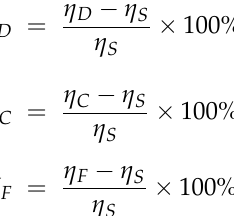
Table 1. Theoretical predictions of collector efficiency η c and improvement I C for I 0 = 830 W/m 2 and I 0 = 1100 W/m 2.